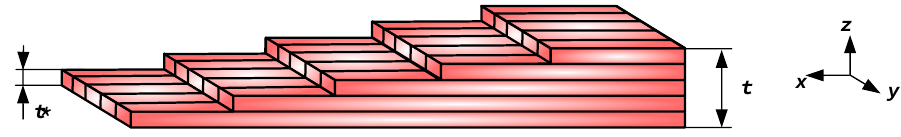
Figure 2. Laminate of the face sheet.